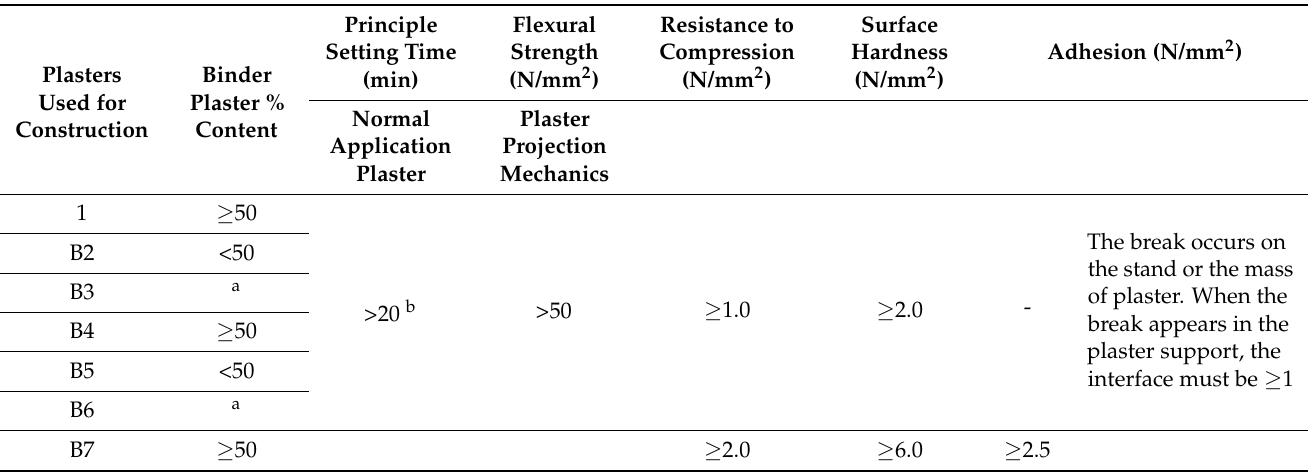
Table 2. Specifications for construction plasters (source: UNE EN 13279-2) [26].